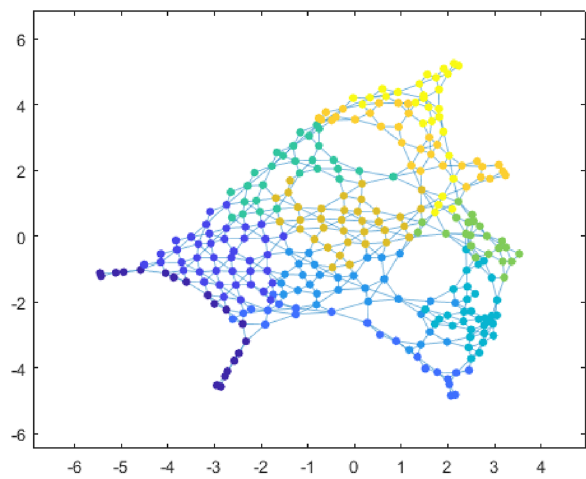
Fig. 7 Simulation result of real scene F 10